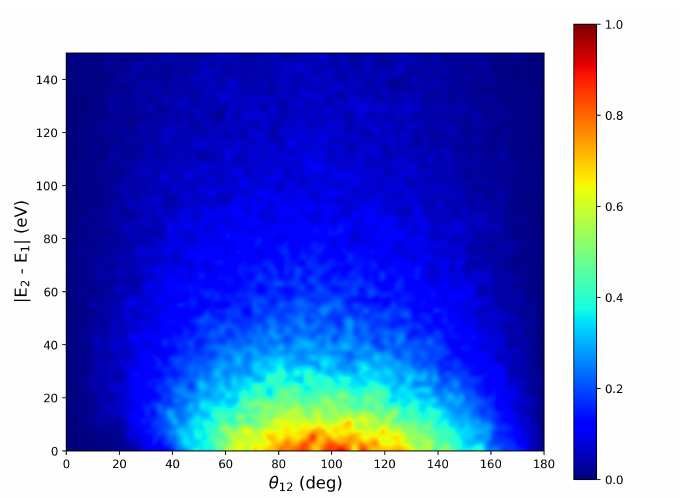
Figure 3. Normalized contour plot of the relative energy of the emitted electrons in double-ionization processes as a function of the interelectronic relative angle.